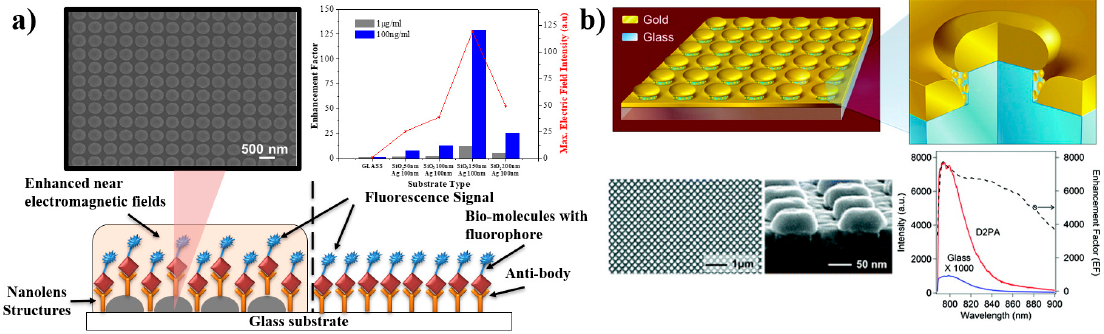
Figure 5. Examples of MEF substrate fabricated by nanoimprint lithography: ( a ) a plasmonic nano-lens array, and ( b ) a disk-coupled dots-on-pillar antenna-array (D2PA) for MEF. Adapted with permission from references [30,122].